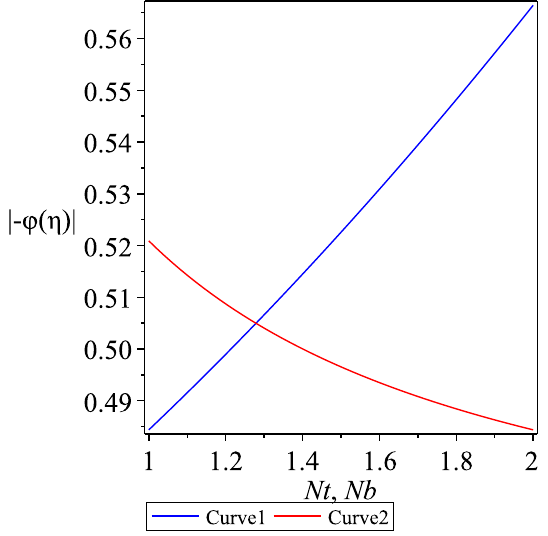
Fig. 13 Plot of |− (cid:98) φ (cid:48) ( 0 ) | , where Curve 1 is |− (cid:98) φ (cid:48) ( 0 ) | versus Nt using Le = 2, Nb = 2, Pr = 1, n = 0 . 5, Curve 2 is |− (cid:98) φ (cid:48) ( 0 ) | versus Nb using Le = 2, Pr = 1, Nt = 1, n = 0 . 5. this inverse linear